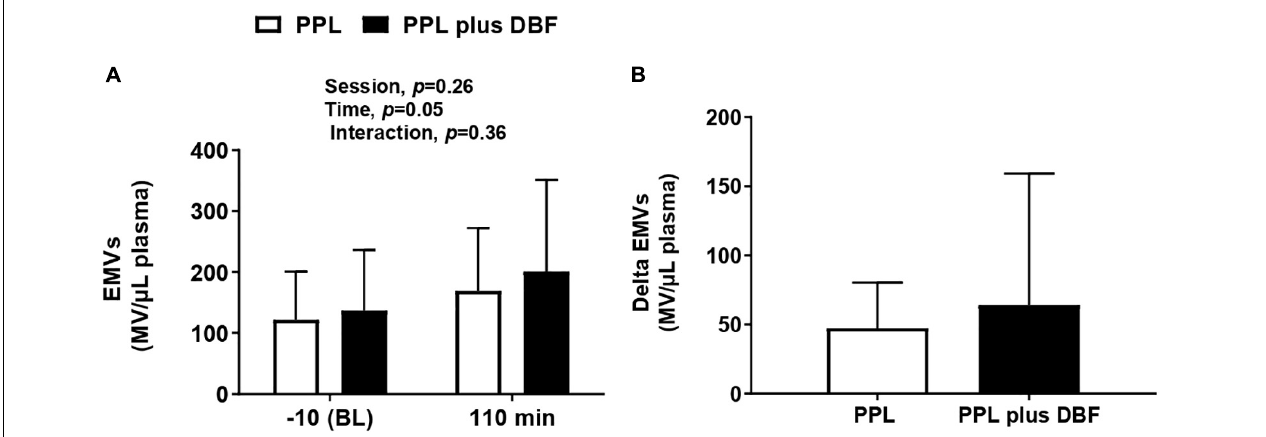
FIGURE 6 | Endothelial microvesicles [ (A) , EMVs] and changes (B) to postprandial lipemia (PPL) and PPL plus disturbed blood flow (DBF) in healthy individuals. Data presented as mean ± standard deviation. Absolute change (delta) was calculated by subtracting values at 110 min from baseline.